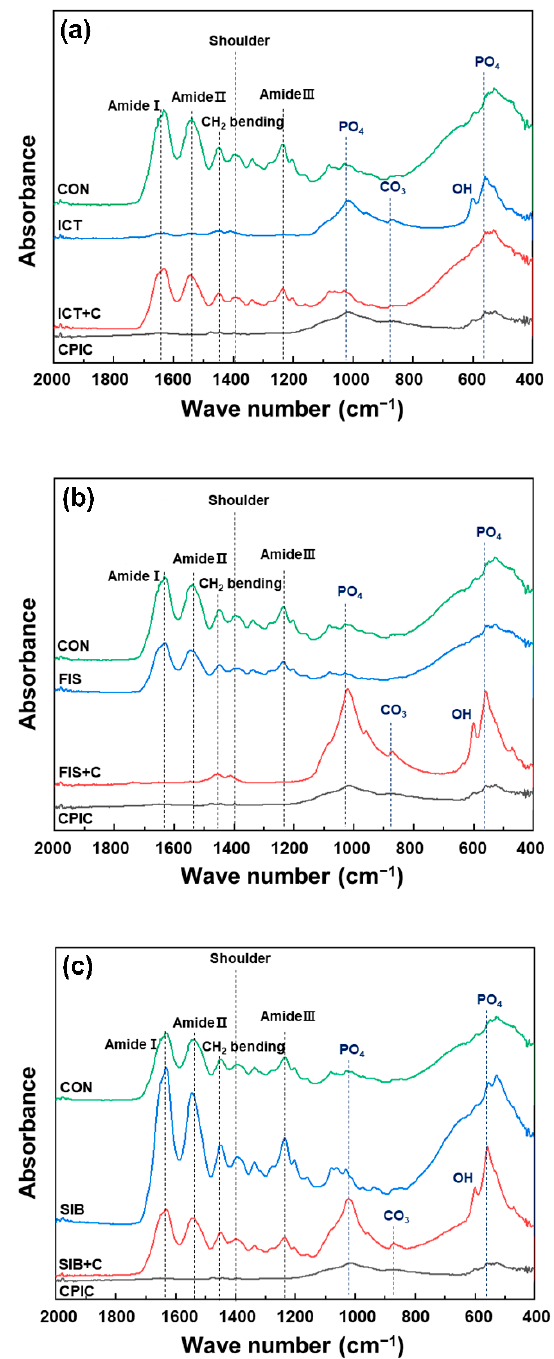
Figure 5. Fourier transform infrared spectroscopy spectra of dentin specimens conditioned with the experimental solutions in comparison with the control group (CON): ( a ) icaritin (ICT) and icaritin combined with CPIC (ICT + C); ( b ) fisetin (FIS) and fisetin combined with CPIC (FIS + C); ( c ) silibinin (SIB) and silibinin combined with CPIC (SIB + C). The flavonoid and CPIC combination groups (ICT + C, FIS + C, and SIB + C) exhibited notable changes in the emergence of chemical functional group spectra characteristic of apatitic materials, including absorption bands of PO 4 3 − antisymmetric stretching mode ( ν 3) at 1080–1000 cm − 1 , PO 4 3 − antisymmetric bending mode ( ν 4) at 570 cm − 1 , OH − at 631 cm − 1 , and CO 3 2 − at 875 cm − 1